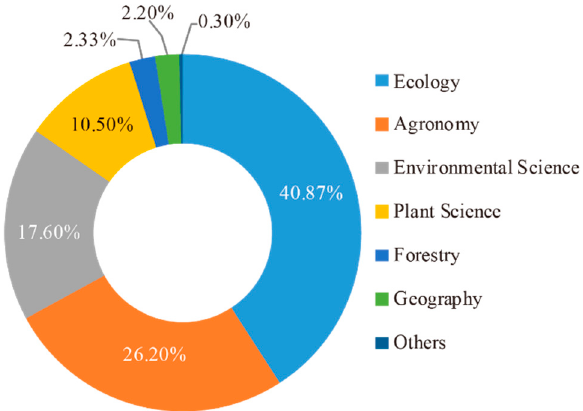
Figure 2. Discipline distribution of publications in the grassland ecosystem field.